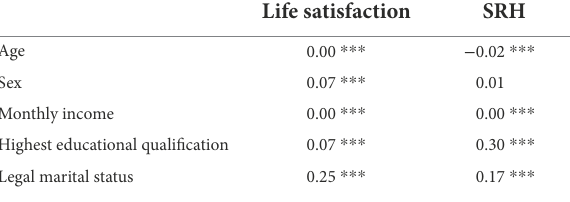
TABLE 2 The estimates ( b ) of linear models trained based on demographic predictors of people without epilepsy.